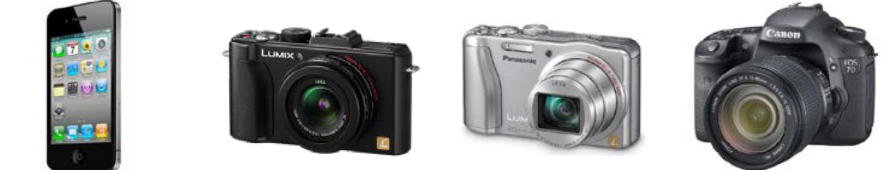
Figure 1. Cameras used in the study (listed according to Table